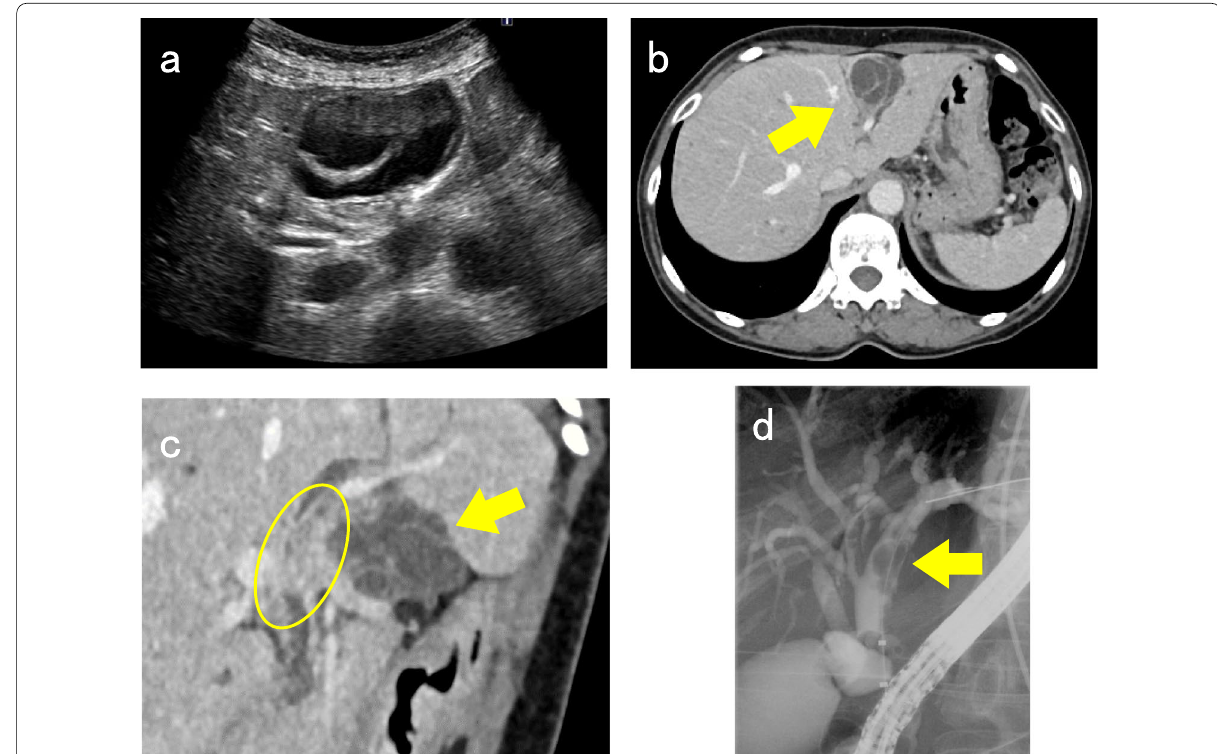
Fig. 1 Imaging examination findings. a Abdominal ultrasonography showed a 49 b Computed tomography (CT) revealed a 4-cm multilocular cystic lesion with multiple septal formations showing a cyst-in-cyst appearance in S4 (arrow). c CT revealed polypoid nodule (oval) protruded in the left hepatic duct from the cystic lesion (arrow). d Endoscopic retrograde cholangiography showed a contrast defect in the left hepatic duct to common bile duct which was suspected to be a nodular lesion in the bile duct